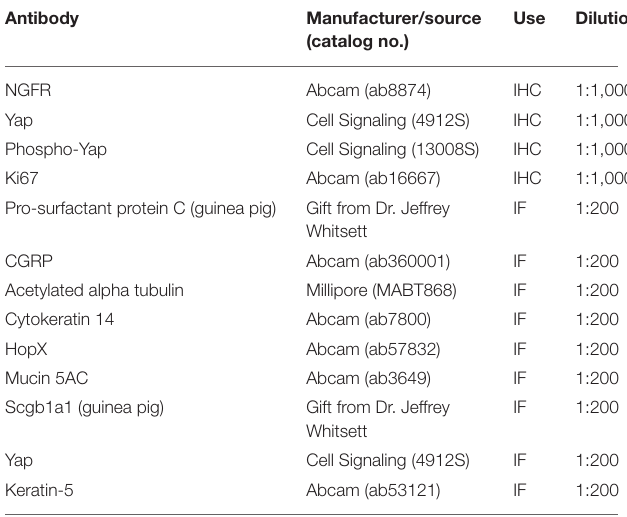
TABLE 1 | Primary antibodies. Antibody Manufacturer/source